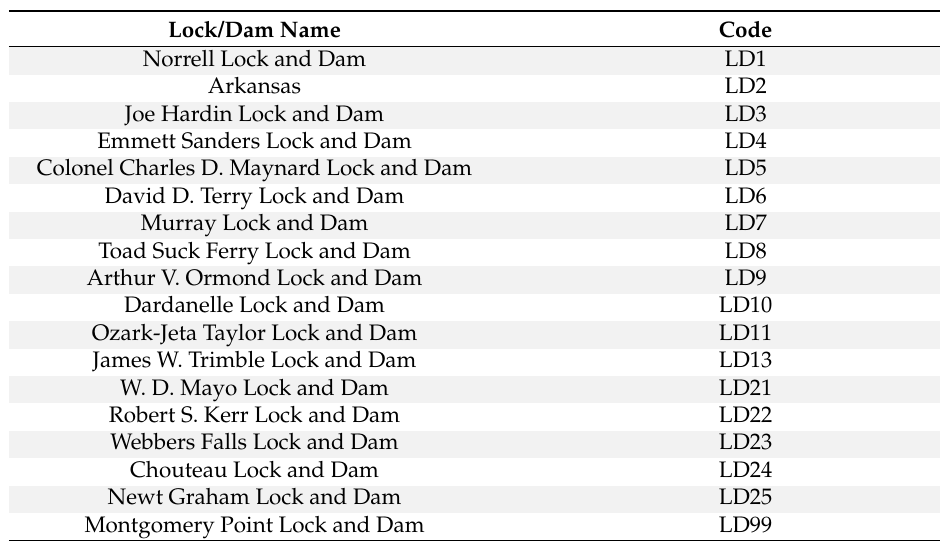
Table A2. Lock and dam